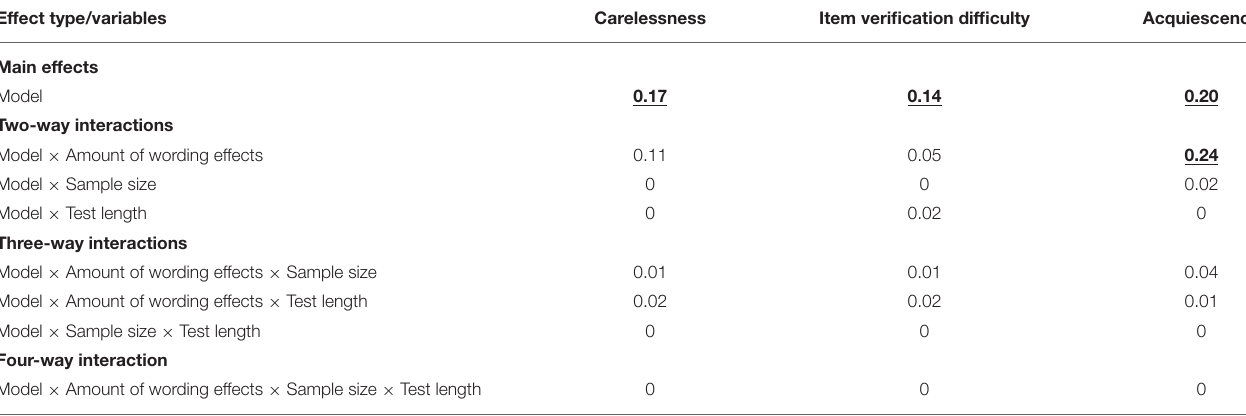
TABLE 2 | Mixed analysis of variance effect sizes for the wording effects of carelessness, item verification difficulty, and